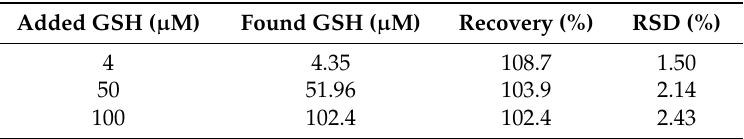
Table 1. N-CNPs for the detection of GSH in fetal calf serum samples. Table 1. Nitrogen-doped CNPs (N-CNPs) for the detection of glutathione (GSH) in fetal calf serum samples.